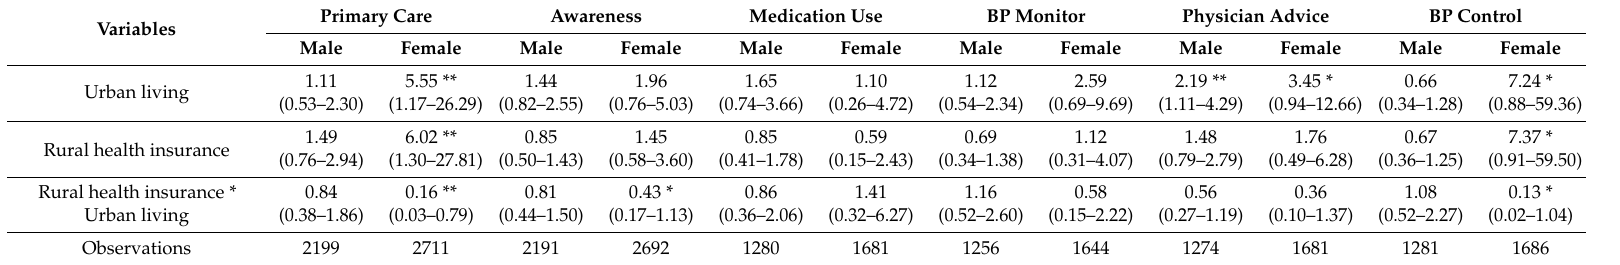
Table 5. Adjusted odds ratios (95% CI) for hypertension management by logistic regression, male/female.